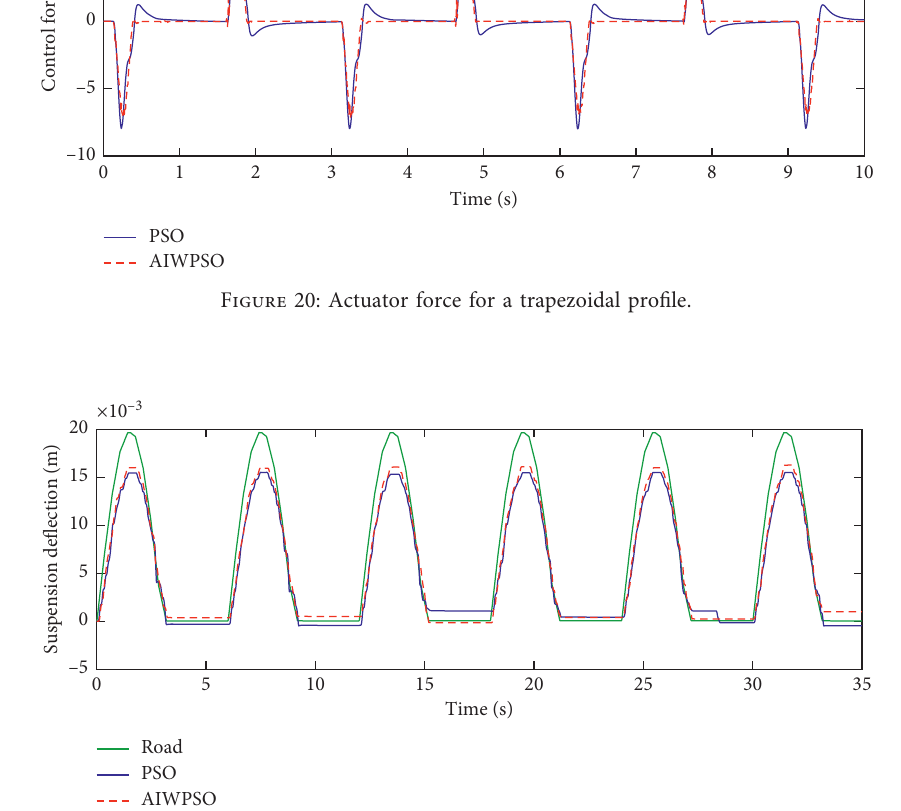
Figure 21: Suspension deflection for a bumpy road profile.